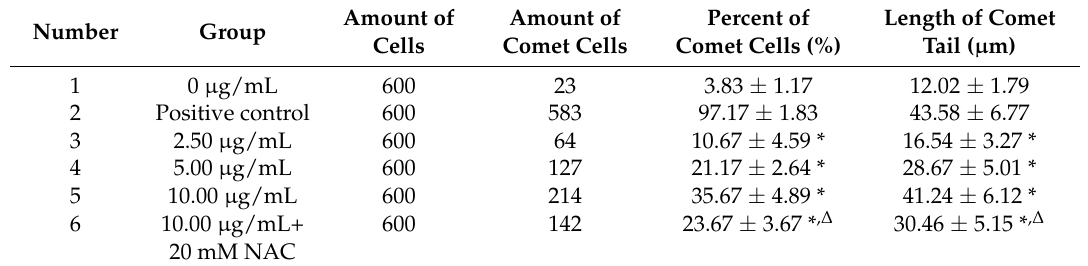
Figure 4. The degree of DNA damage of hepatocytes exposed to aniline for 24 h. ( a ) 0 μ g/mL; ( b ) 2.50 μ g/mL; ( c ) 5.0 μ g/mL; ( d ) 10.0 μ g/mL; ( e ) 10.0 μ g/mL + 20 mmol/L NAC; ( f ) positive control (H 2 O 2 ). (Original magnification 100×). Table 1. Degree of DNA damage in hepatocytes exposed to aniline for 24 h. Table 1. Degree of DNA damage in hepatocytes exposed to aniline for 24 h.